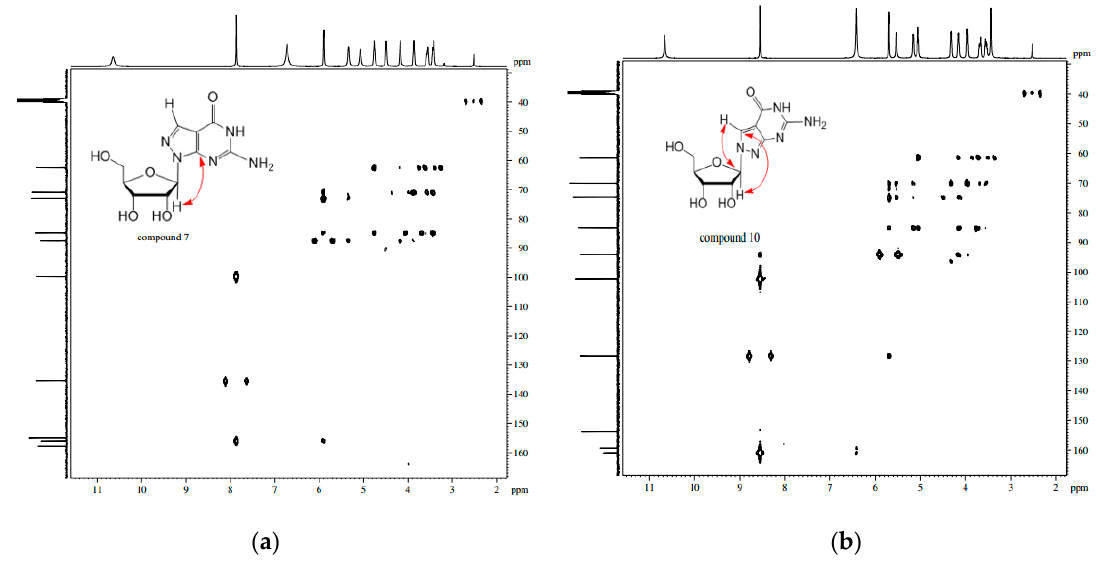
Figure 4. HMBC spectra of compounds 7 ( a ) and 10 ( b ).